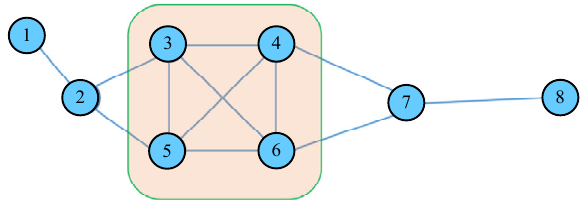
Fig. 9 Max clique. The nodes are loop-closure and dark-areas are the